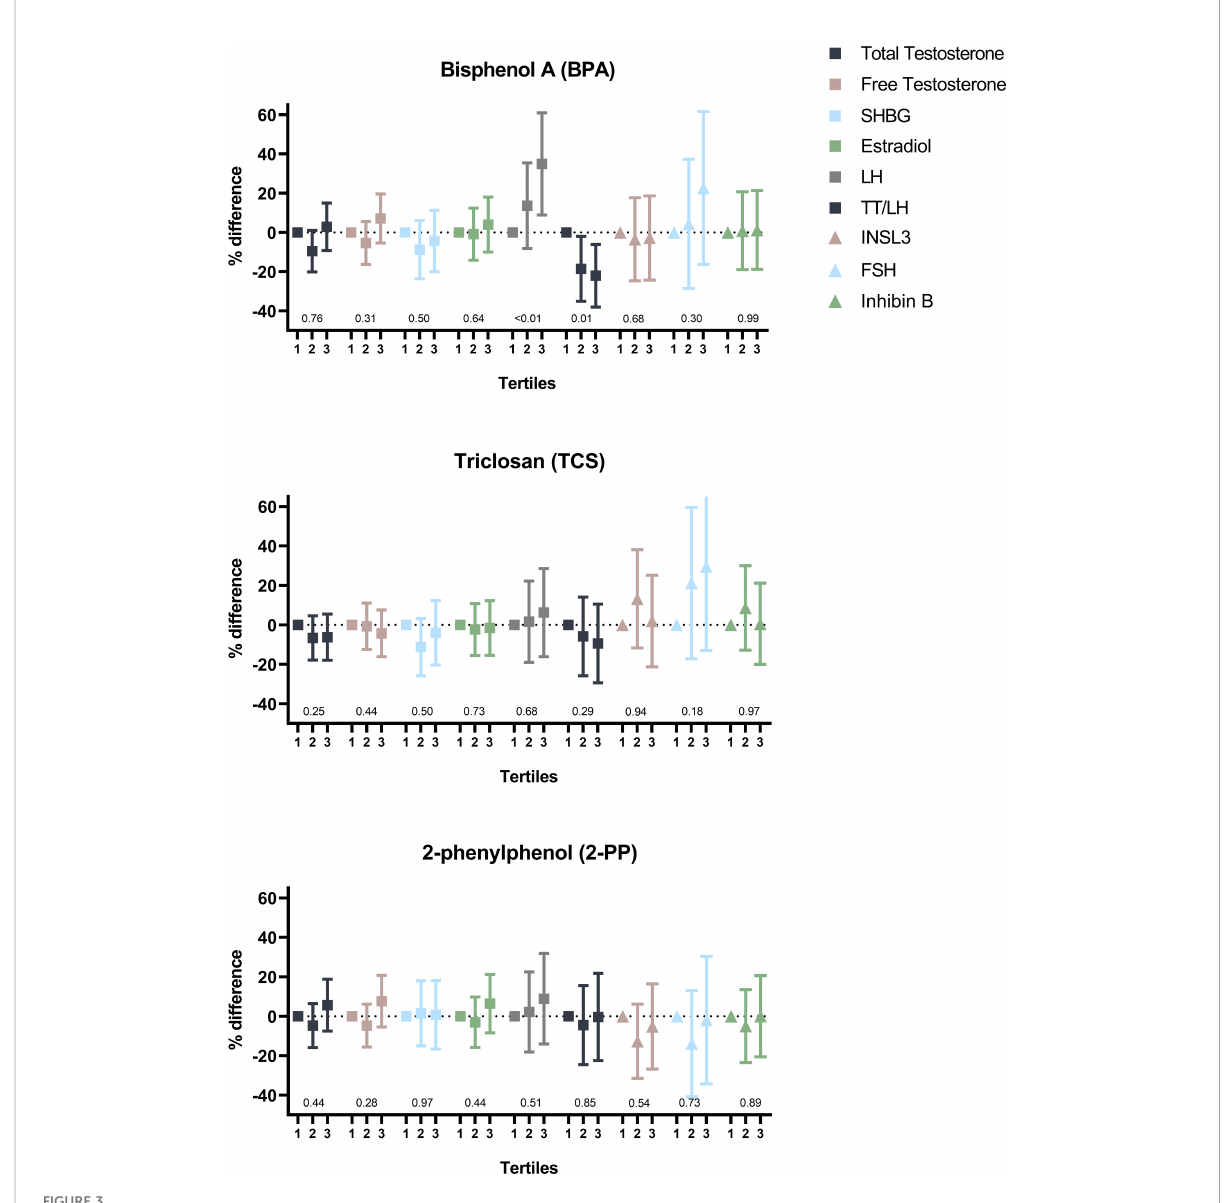
FIGURE 3 Percentage difference in levels of serum hormone concentrations according to tertiles of prenatal phenol exposure levels adjusted for confounders. P-values indicate trend across categories. SHBG, sex hormone-binding globulin; LH, luteinizing hormone; TT/LH, total testosterone/Luteinizing hormone ratio; INSL3, Insulin-like factor 3; FSH, follicle stimulating